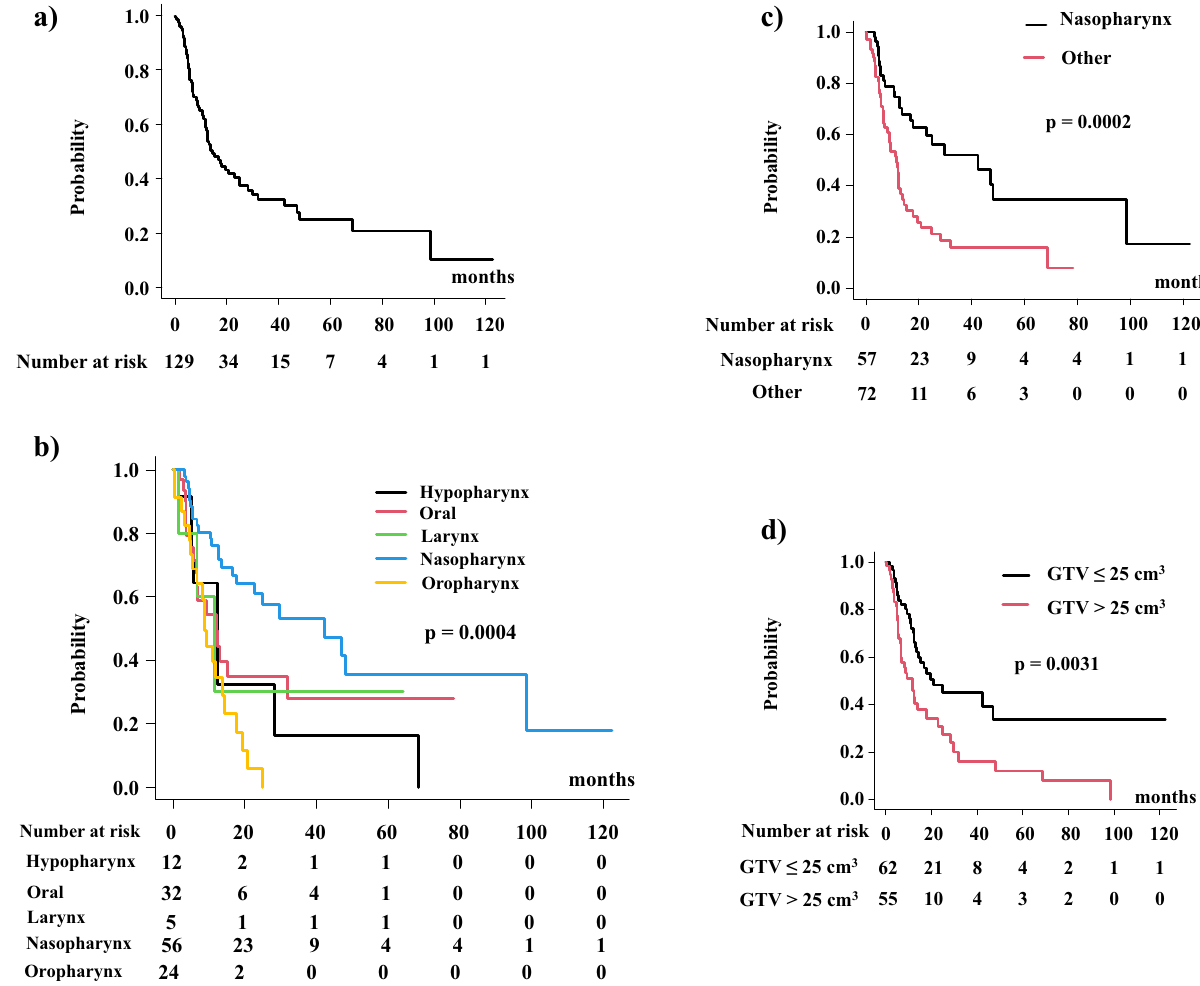
Figure 1. Overall survival rate (OS). ( a ) OS in the entire population. ( b ) OS according to primary sites. ( c ) OS according to nasopharyngeal cancer or not. ( d ) OS according to volumes of GTV.